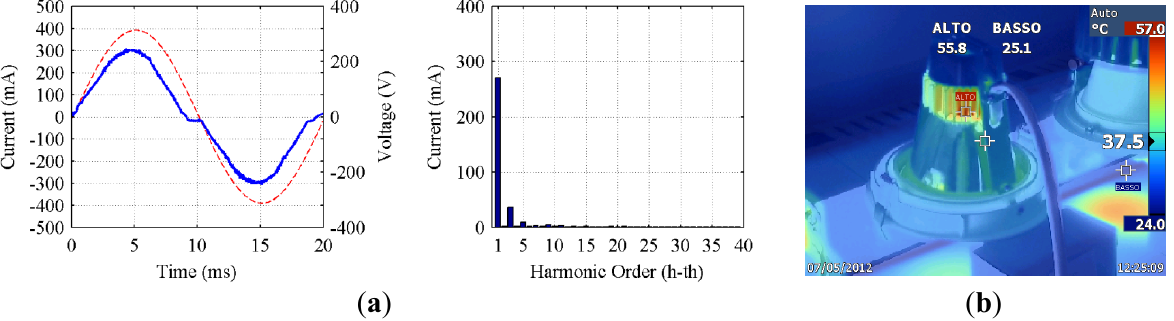
Figure 8. Type C LED spot: ( a ) Current waveform and its spectrum; ( b ) Thermal image.